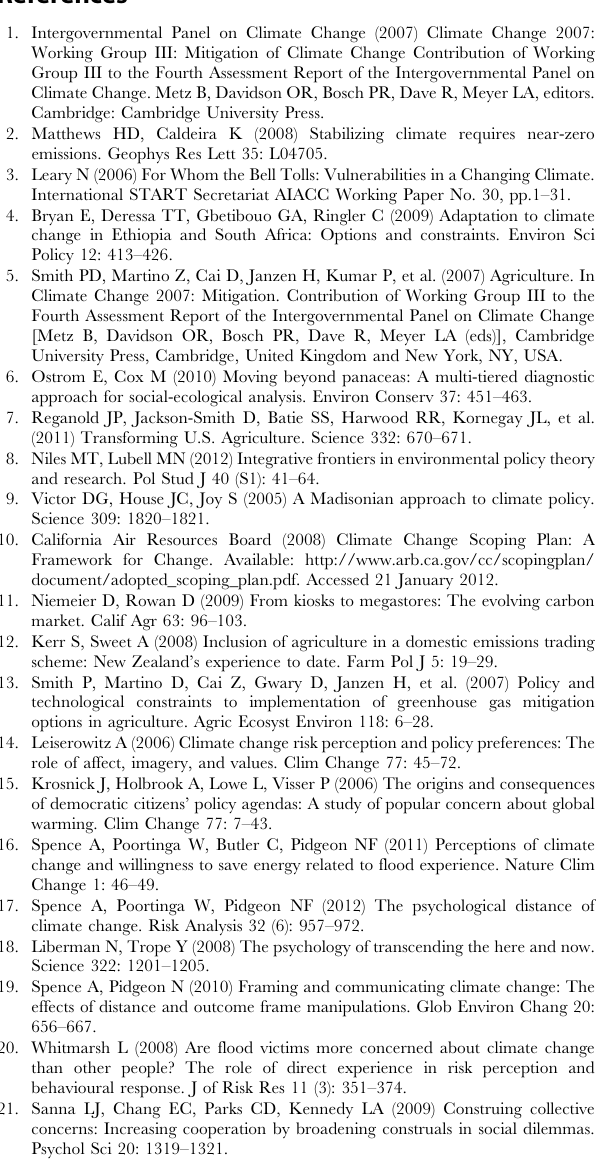
Table S2 Survey response rate calculations according to AAPOR methods. Table S3 Survey questions, scales, eigenvalues, factor loadings and reliability coefficients (Cronbach’s a ) for variables used in the multiple-mediation models. Table S4 Indirect and direct effect estimations for the multiple-mediation